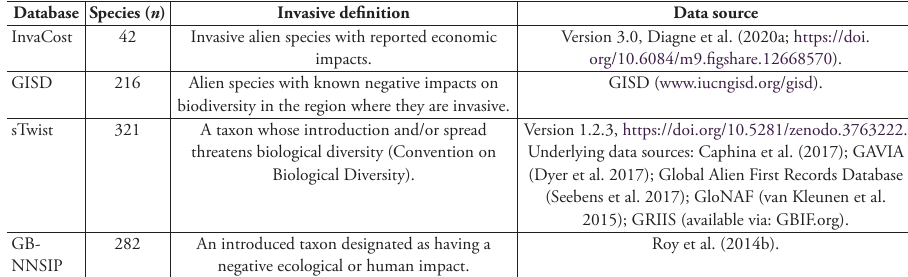
Table 1. Initial numbers of known invasive species extracted from the InvaCost, GISD, sTwist and GB- NNSIP databases for the UK. Definitions of invasiveness are provided in relation to each database, along with underlying sources of data